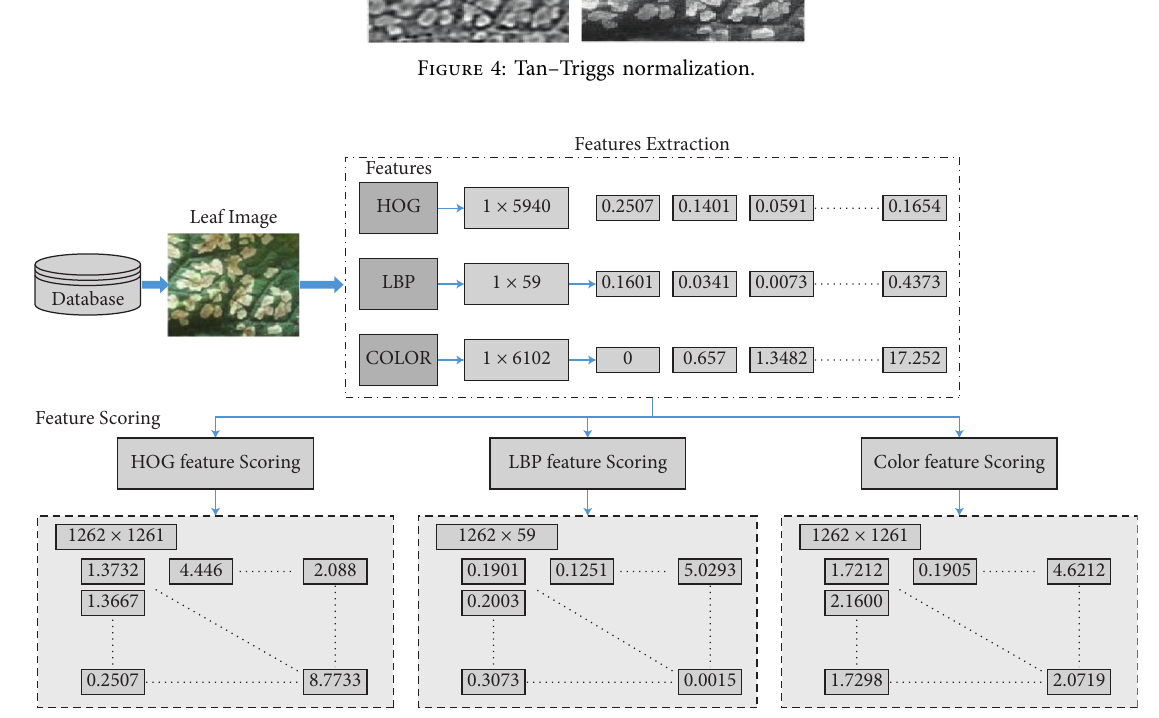
Figure 5: Features extraction and features scoring of HOG, LBP, and color, respectively.